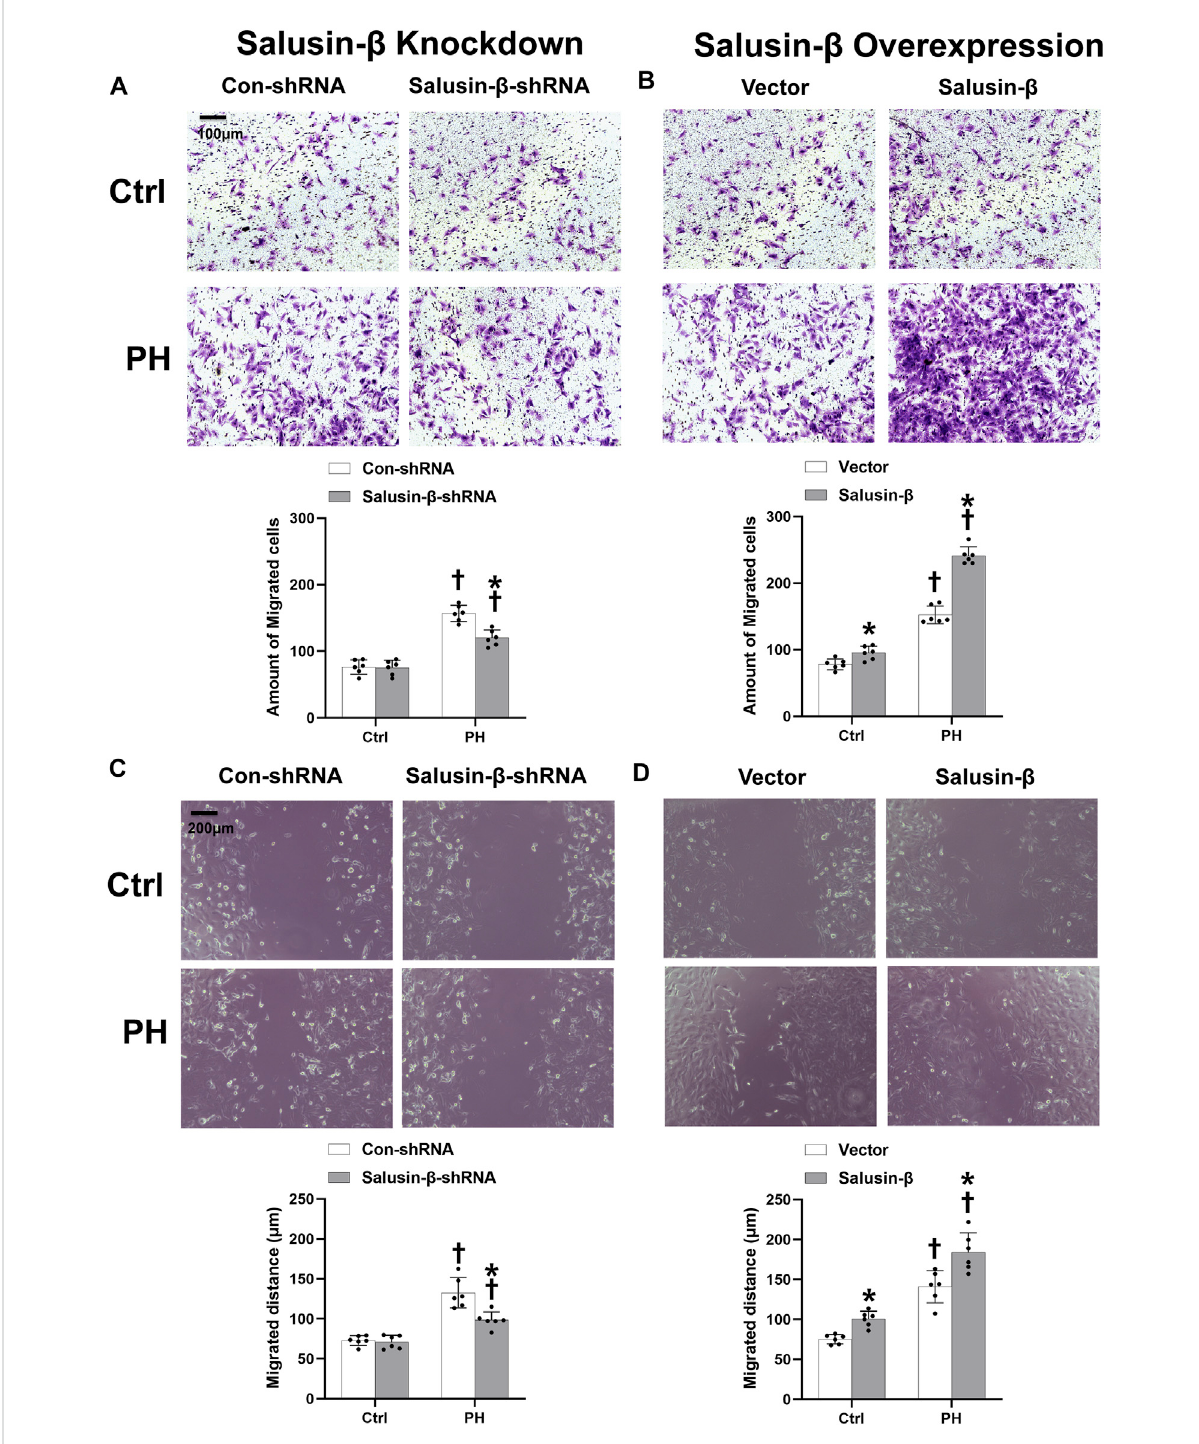
FIGURE 6 Effects ofsalusin- β knockdown on PASMCs migration evaluated by the boyden chamber assay (A) and awound healing assay (C) ; as well as the effectsofoverexpressionofsalusin- β onPASMCsmigrationevaluatedbytheboydenchamberassay (B) andawoundhealingassay (D) incontroland MCT-induced PH rats. Values are mean ± SE. * p < 0.05 compared with Con-shRNA or vector. † p < 0.05 compared with control (Ctrl) rats. n = 6 for each